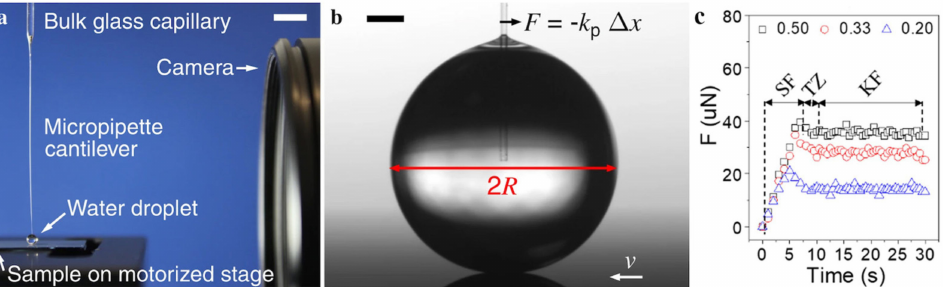
Figure 31. ( a ) Optical image of an MFS setup with a droplet deposited on a SH surface. A water drop is suspended from a force-calibrated micropipette cantilever; ( b ) high magnification image of a water drop attached to a capillary tube. While the stage moves, the drop experiences a friction force thereby deflecting the capillary tube [227]; and ( c ) friction force versus time on three microstriped surfaces with different fractional areas. A capillary force sensor is able to differentiate the different phases of the friction including the static friction (SF), transition zone (TZ), and kinetic friction (KF). (Reprinted from [173] with permission from Elsevier).